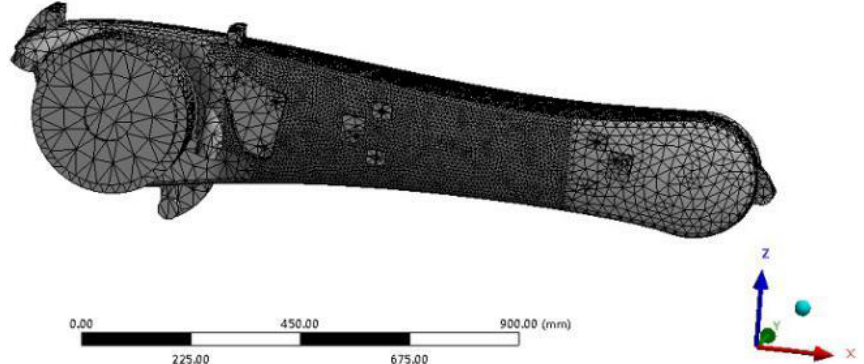
Figure 7. Robot arm forearm grid division.